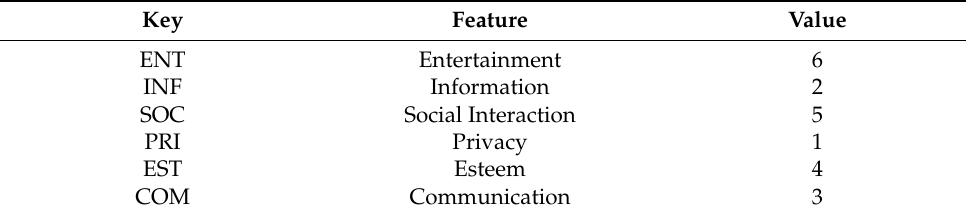
Table 3. Criteria importance. Key Feature Value ENT Entertainment INF